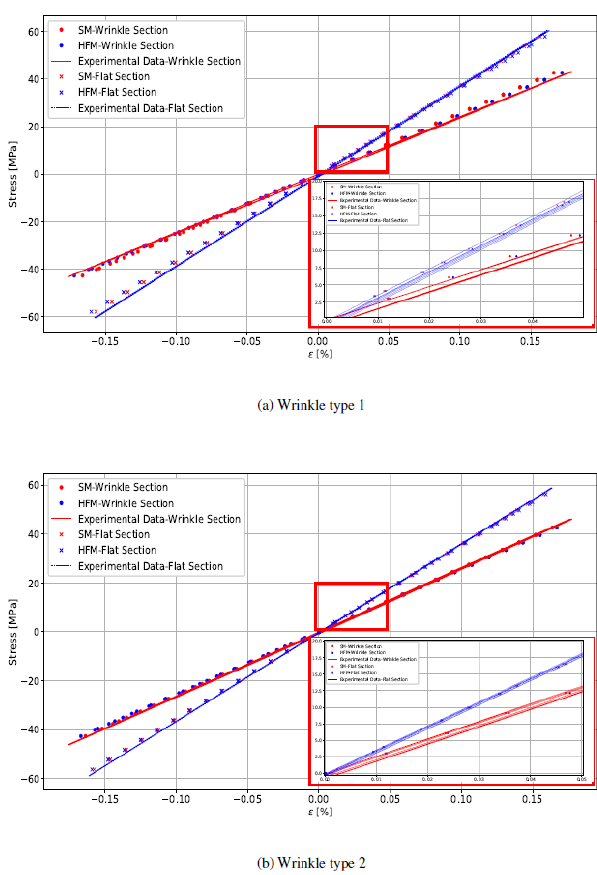
Figure 11. Prediction of numerical model results against experi- mental tests for coupon specimens with two configurations of wrin-